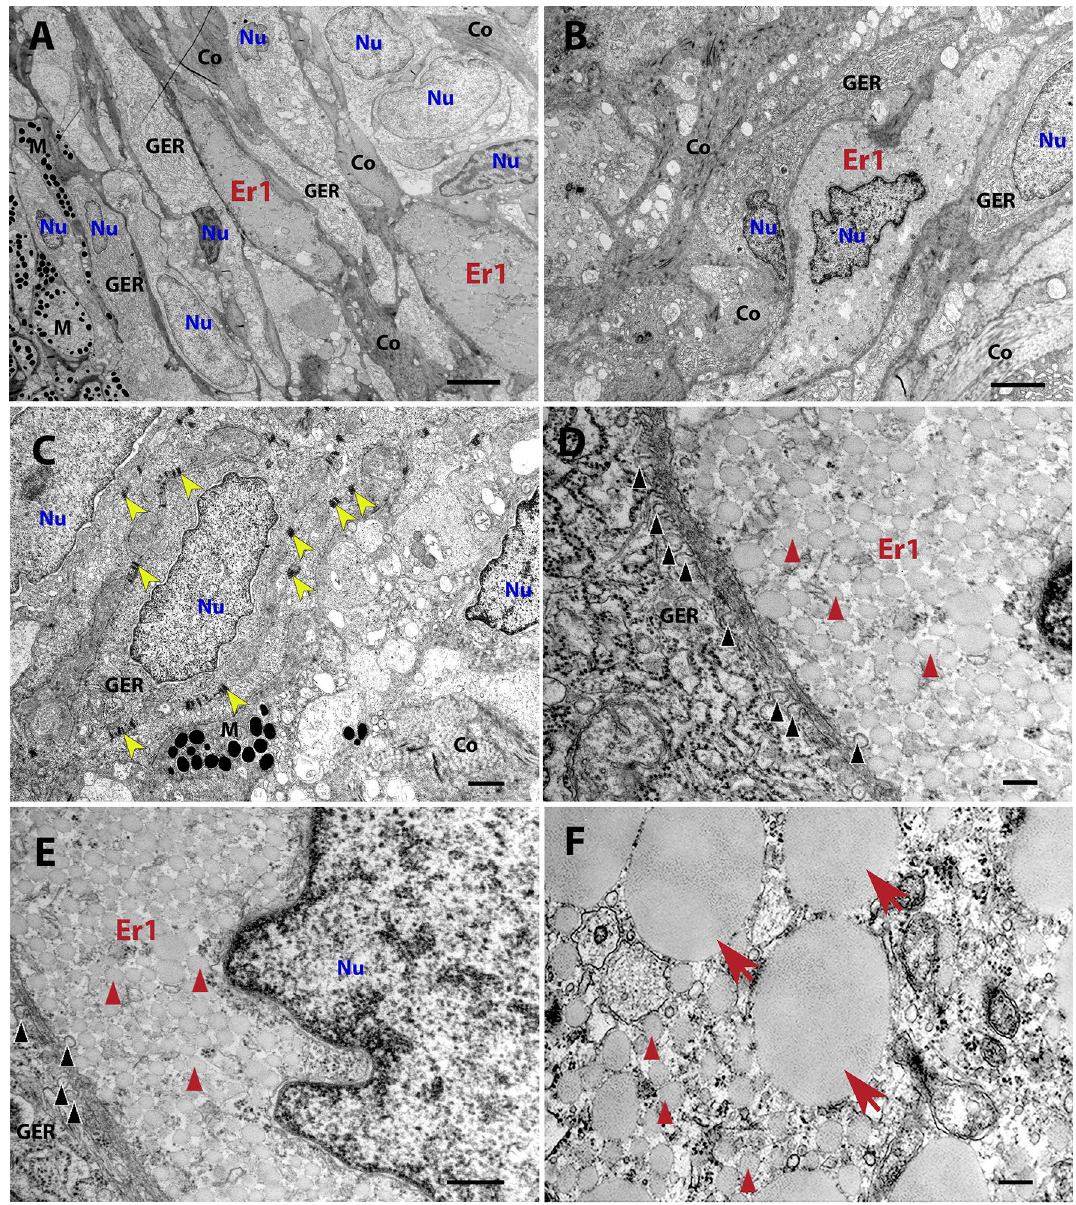
Figure 1. TEM images showing type 1 erythrophores from black spots. ( A ) A low magnification image of the dermis. Melanophores are positioned directly under the epidermis (on the left side). Type 1 erythrophores lie beneath melanophores. ( B ) Type 1 erythrophores surrounded by cells filled with closely packed sheets of GER and extracellular matrix with abundant collagen fibres (Co). ( C ) Desmosomes (yellow arrowheads) connecting the cells in the dermis. ( D – E ) Higher magnification images of areas from ( B ), showing the ultrastructure of type 1 erythrophore. Black arrowheads point to many caveolae between type 1 erythrophores and GER-filled cells (fibroblasts). Red arrowheads point to carotenoid vesicles. ( F ) Ultrastructure of type 1 erythrophore with carotenoid vesicles (red arrowheads) and some bigger, erythrosome-like inclusions (red arrows), while red arrows point to bigger, erythrosome-like inclusions. Co collagen fibres, Er1 type 1 erythrophore, GER granular endoplasmic reticulum, M melanophore, Nu nucleus. Scale bars: 4 μm ( A ); 2 μm ( B ); 1 µm ( C ); 200 nm ( D , F ); 400 nm ( E